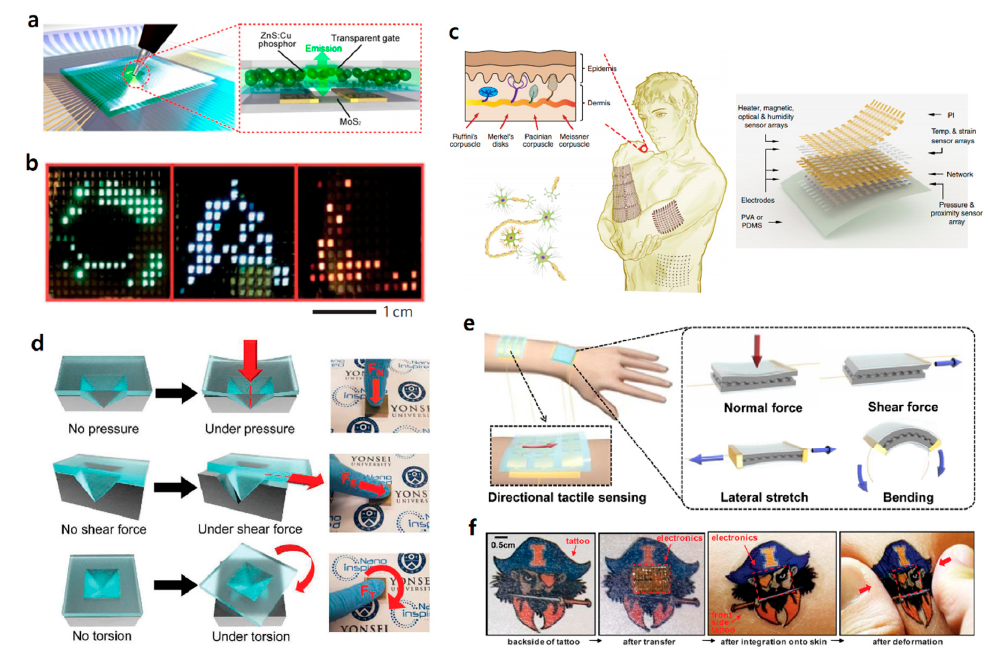
Figure 7. Multimodal, multifunctional tactile sensor arrays based on FETs. ( a ) Schematic layouts of the pressure-sensor array integrated with ZnS:Cu phosphor particles. ( b ) Green, blue, and red color interactive e-skins are used to spatially map and display the pressure applied with C-(left), A-(center) and L-(right) shaped PDMS slabs, respectively. ( c ) Skin-inspired highly stretchable and conformable matrix networks; a schematic illustration of stretchable and conformable matrix networks (SCMNs) conforming to the surface of a human arm and an expanded network (expansion: 200%) conforming to the surface of a human abdomen (right); the tree branch-like connections of neurons (left bottom); the sensory receptors of the glabrous skin (left top). ( d ) Schematic illustrations without stimulus and under three different mechanical stimuli for pressure, shear force, and torsion. There were possible geometric deformations of the pyramid-plug structure with mechanical loadings. ( e ) Schematic of a stress-direction-sensitive electronic skin for the detection and differentiation of various mechanical stimuli including normal, shear, stretching, bending, and twisting forces. ( f ) A commercial temporary transfer tattoo provides an alternative to polyester/polyvinyl alcohol (PVA) for the substrate; in this case, the system includes an adhesive to improve bonding to the skin. Images are of the back side of a tattoo (far left), electronics integrated onto this surface (middle left), and attached to the skin with electronics facing down in undeformed (middle right) and compressed (far right) states. (a)